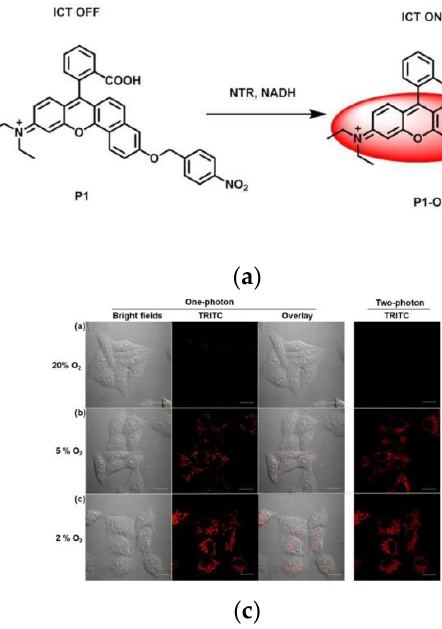
Figure 11. ( a ) Design of probe P1 and its sensing principles; ( b ) Fluorescence spectra of P1 toward series concentrations of NTRs in the being of NADH; ( c ) Fluorescent images for tracing NTRs in HepG2 cells. Reproduced with permission from [63]. Copyright 2021 Elsevier B.V.